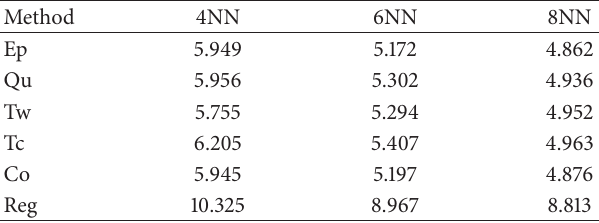
Table 8: Calculating missing precipitation for 2010-02-12 (actual value is 6) with six different